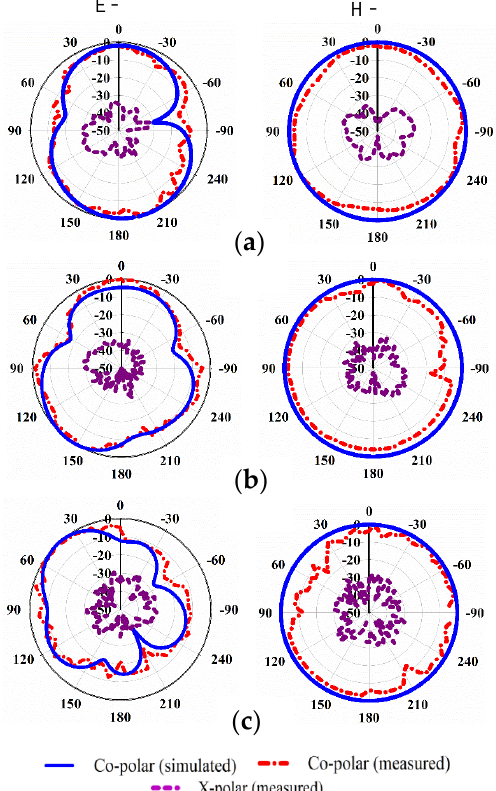
Figure 17. Simulated and measured radiation patterns of the proposed antenna at: ( a ) 4 GHz, ( b ) 8 GHz, and ( c ) 11 GHz.